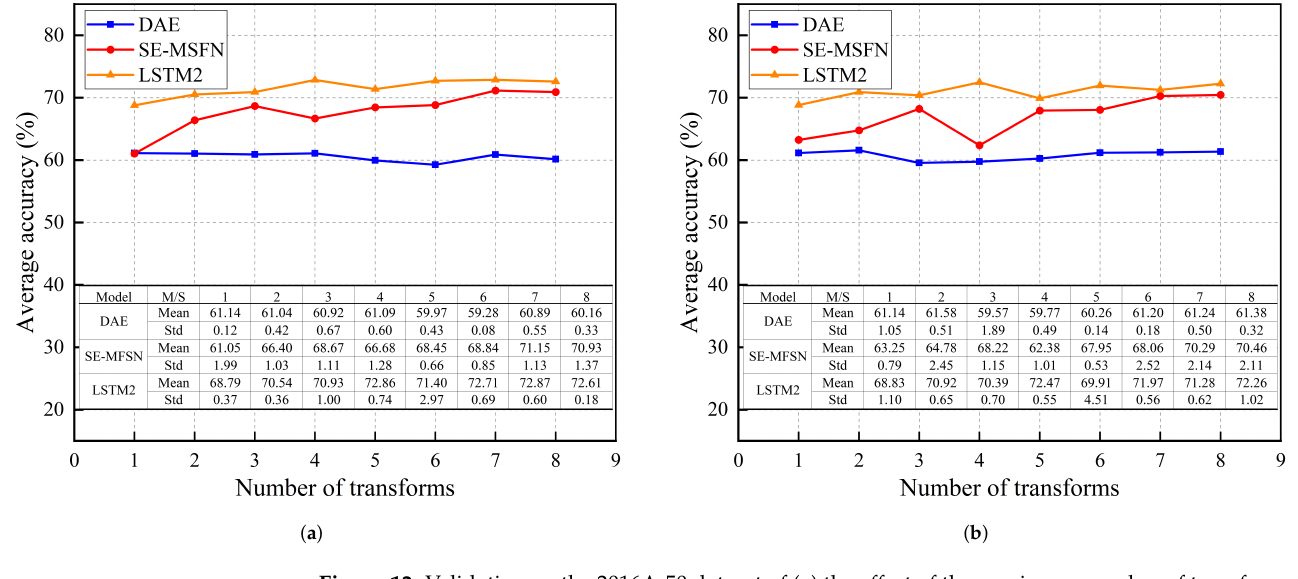
Figure 12. Validation on the 2016A-50 dataset of ( a ) the effect of the maximum number of transforma- tions on SigAugment-R and ( b ) the effect of the number of transformations on SigAugment-C. Table 7. Comparison of the proposed method with the joint augmentation